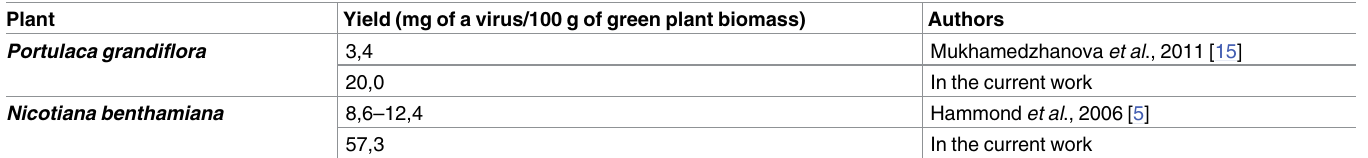
Table 1. Yield of AltMV isolated from various plants. Plant Yield (mg of a virus/100 g of green plant